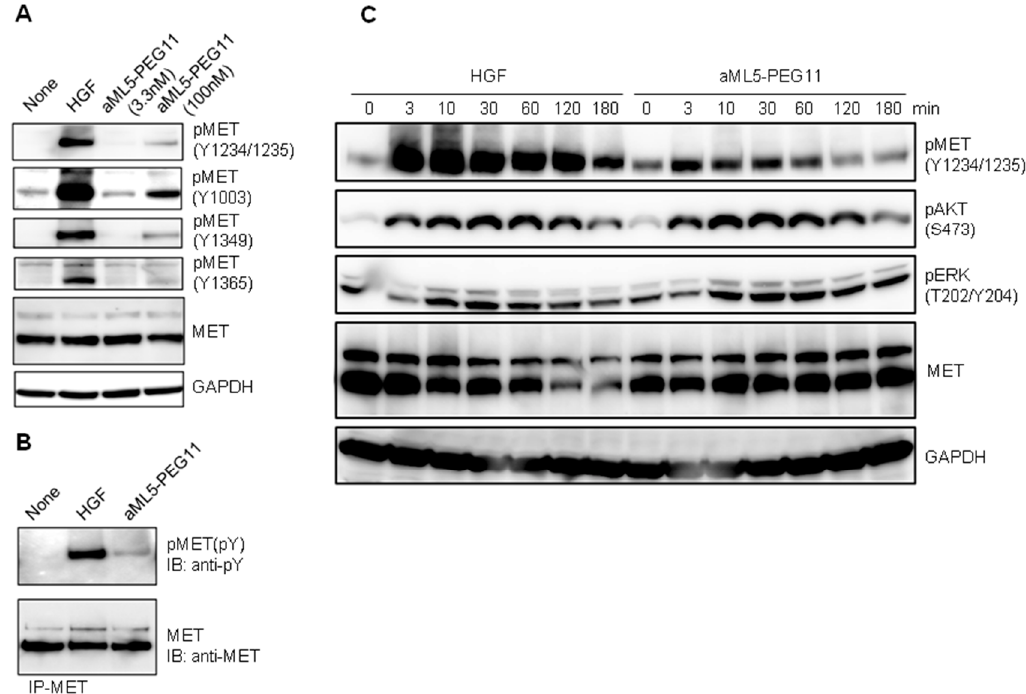
Figure 3. Phosphorylation profiles in the MET receptor AKT and ERK by aML5-PEG11. ( A ) Phosphorylation in individual tyrosine residues in MET receptors. EHMES-1 cells were treated with aML5-PEG11 or 3.3 nM HGF for 10 min. MET receptor phosphorylation at Y1003, Y1234/1235, Y1349, and Y1365 were measured by Western blotting. GAPDH was monitored to ensure equal loading. ( B ) MET receptor phosphotyrosine levels demonstrated by MET immunoprecipitation and Western blotting using anti-phosphotyrosine antibody. EHMES-1 cells were treated with 100 nM aML5-PEG11 or 3.3 nM HGF for 10 min. ( C ) Time-dependent changes in MET receptor, AKT, and ERK phosphorylation. HuCCT1 cells were treated with 100 nM aML5-PEG11 or 3.3 nM HGF. GAPDH was monitored to ensure equal loading. In A, B, and C, the experiments were performed once.